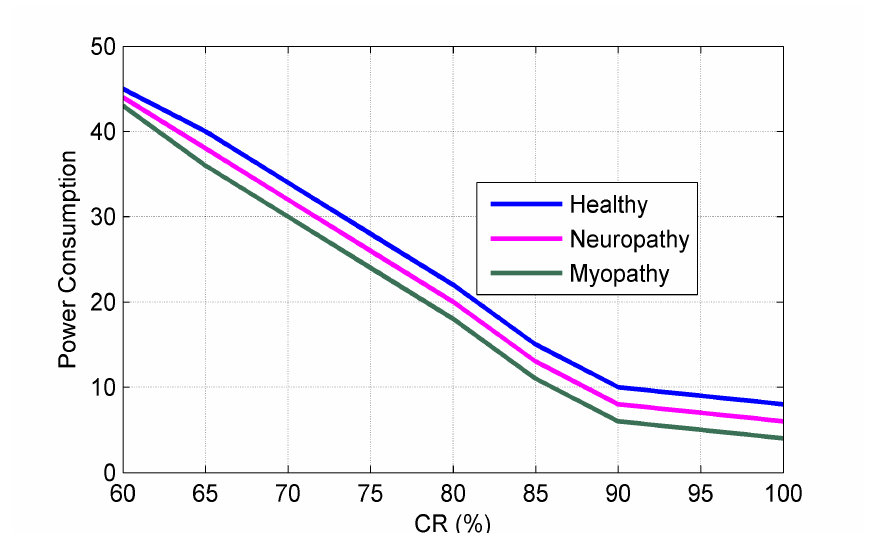
Figure 11. Normalized power